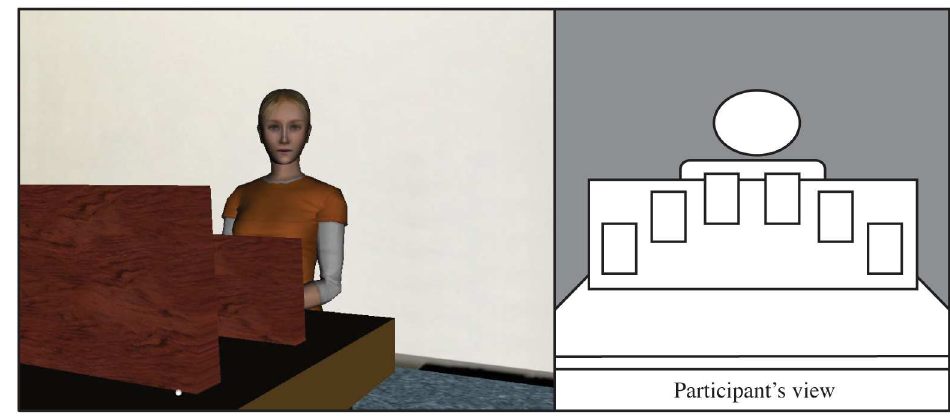
Fig 1. Avatarand Set-up. A. The exterior of the avatar was identicalfor all avatar partners. B. The experimental set-up from the view of the participant.